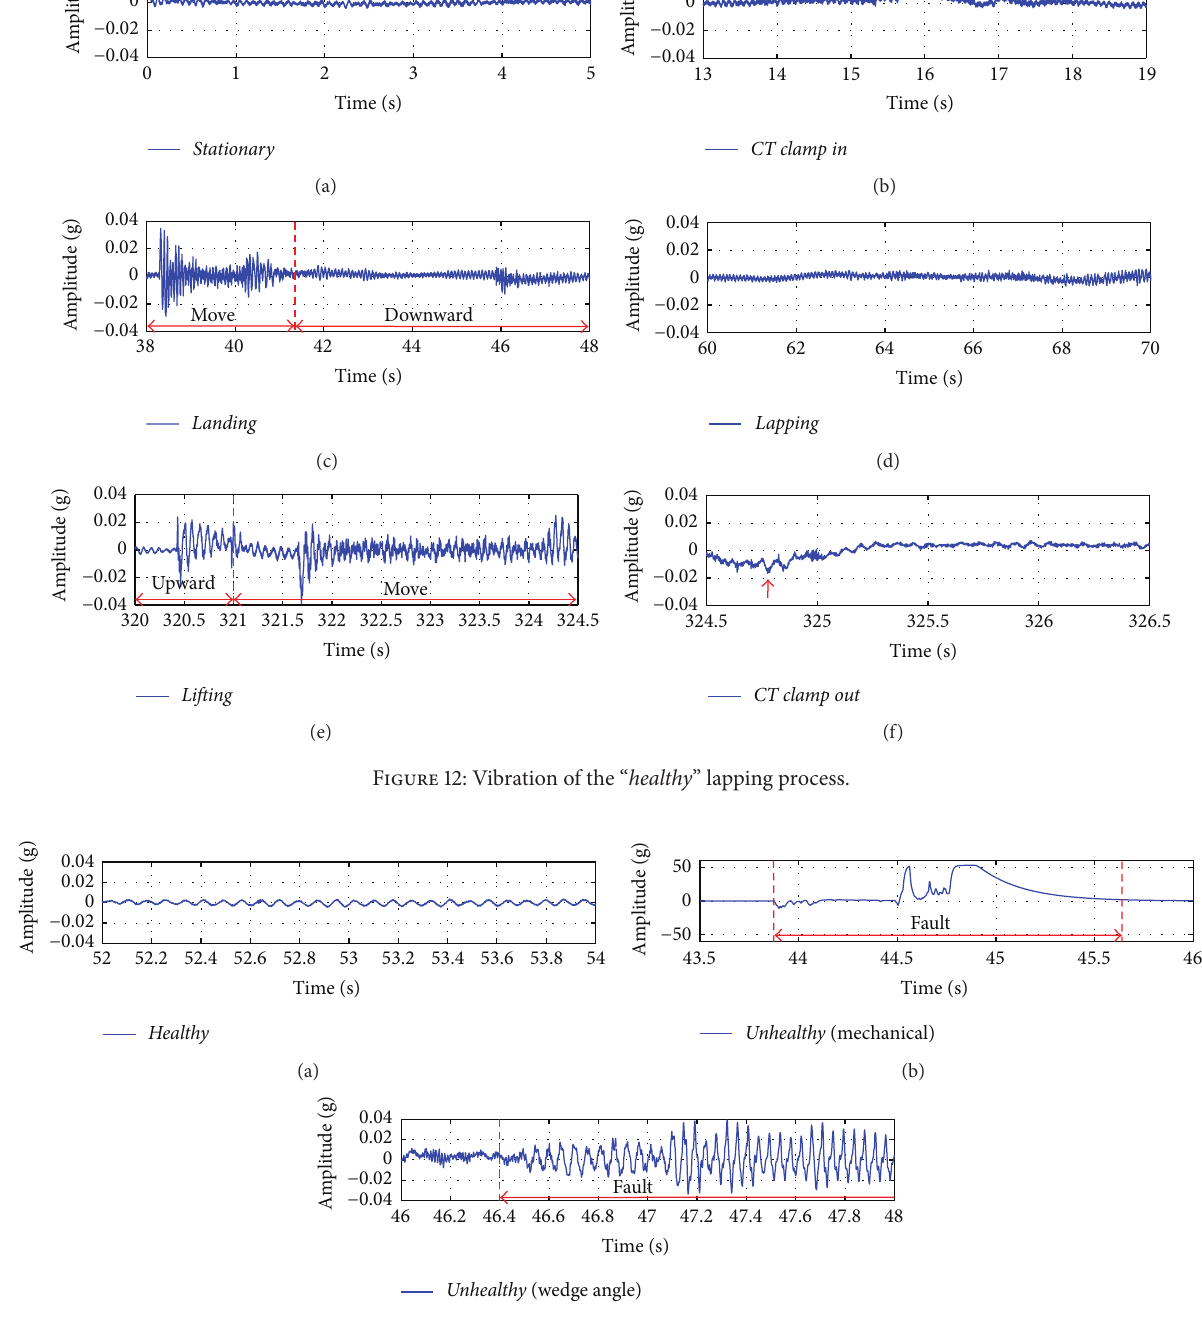
Figure 13: Vibration during lapping of the “ healthy ” and “ unhealthy ”